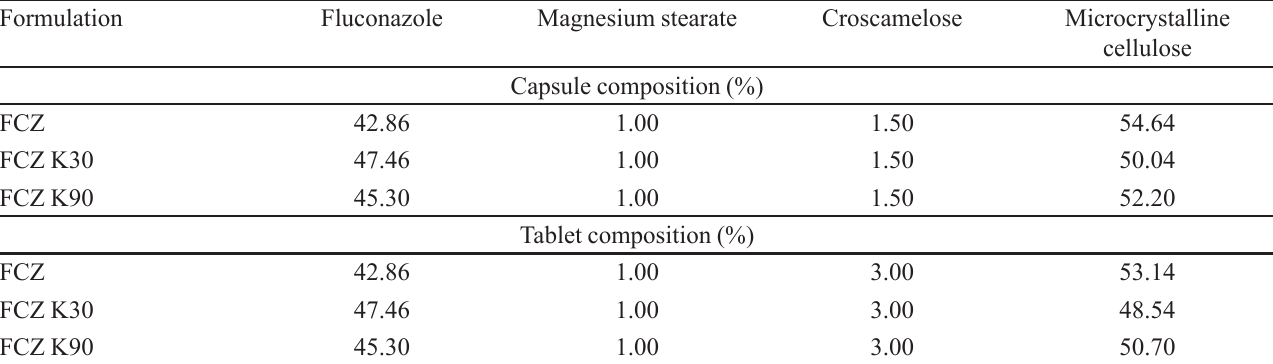
TABLE I - Compositions of capsules and tablets produced with fluconazole (FCZ), and fluconazole granules (FCZ K30 and FCZ K90). Formulation